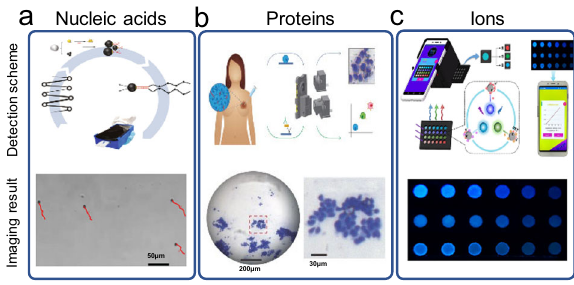
Fig.8|MoleculardiagnosisonmHealthplatforms.a Nucleicacidsdetection.The fi gure illustrates the detection of HIV-1 nucleic acids using a cellphone system integrating cellphone-based optical sensing, loop-mediated isothermal ampli fi ca- tion, and micromotor motion ( fi gure adapted with permission from Draz et al. 11 ). b Protein detection. The fi gureillustrates the work fl ow for breast cancer diagnosis using a mobile pathology platform ( fi gure adapted with permission from Joh et al. 114 ). c Ion detection. The fi gure illustrates the work fl ow for the detection of Hg 2+ , Pb 2+ ,andCu 2+ inwatersamples( fi gureadaptedwithpermissionfromXiaoetal. 122